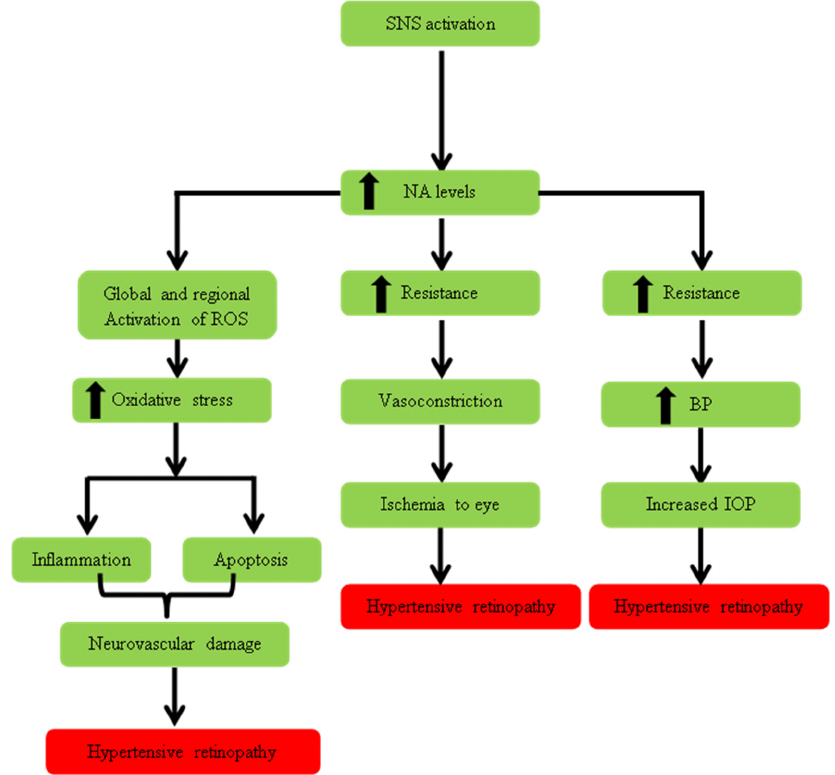
Figure 6. Role of SNS in the pathogenesis of hypertensive retinopathy. The figure illustrates the role of the sympathetic nervous system (SNS) in the pathogenesis of hypertensive retinopathy by following three mechanisms. One mechanism led to oxidative stress which resulted in inflammation and apoptosis. Both factors lead to neurovascular damage in the eye which results in the development of hypertensive retinopathy. The other 2 pathways are related to an increase in resistance due to increased SNS tone which resulted in ischemia of the eye in one case, while in other case it increased intraocular pressure. Both ischemia and IOP lead to hypertensive retinopathy.